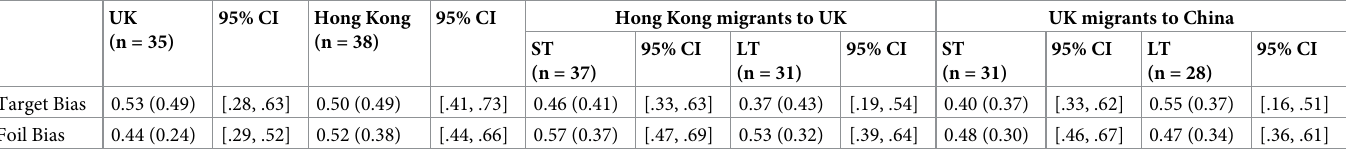
Table 2. Means (standard deviations) on similarity ratings task (similarity ratings, 1, different– 4, similar).